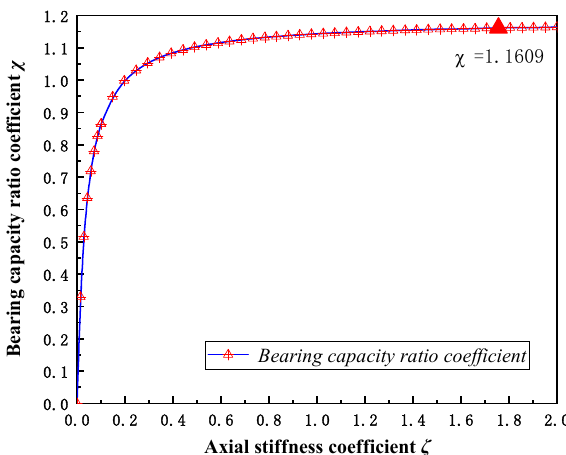
Figure 12. Bearing capacity variation coefficient curve. According to Equation (18), take 1 5 ζ= to calculate the tower bearing capacity as the reference bearing capacity, and 1 5 ~ 3 ζ= to calculate the stable bearing capacity of the tower, respectively, and take the ratio coefficient to the benchmark bearing capacity χ χ , The relationship curve between the ratio coefficient 1 and the axial stiffness change coefficient ζ is obtained, as shown in Figure 13.